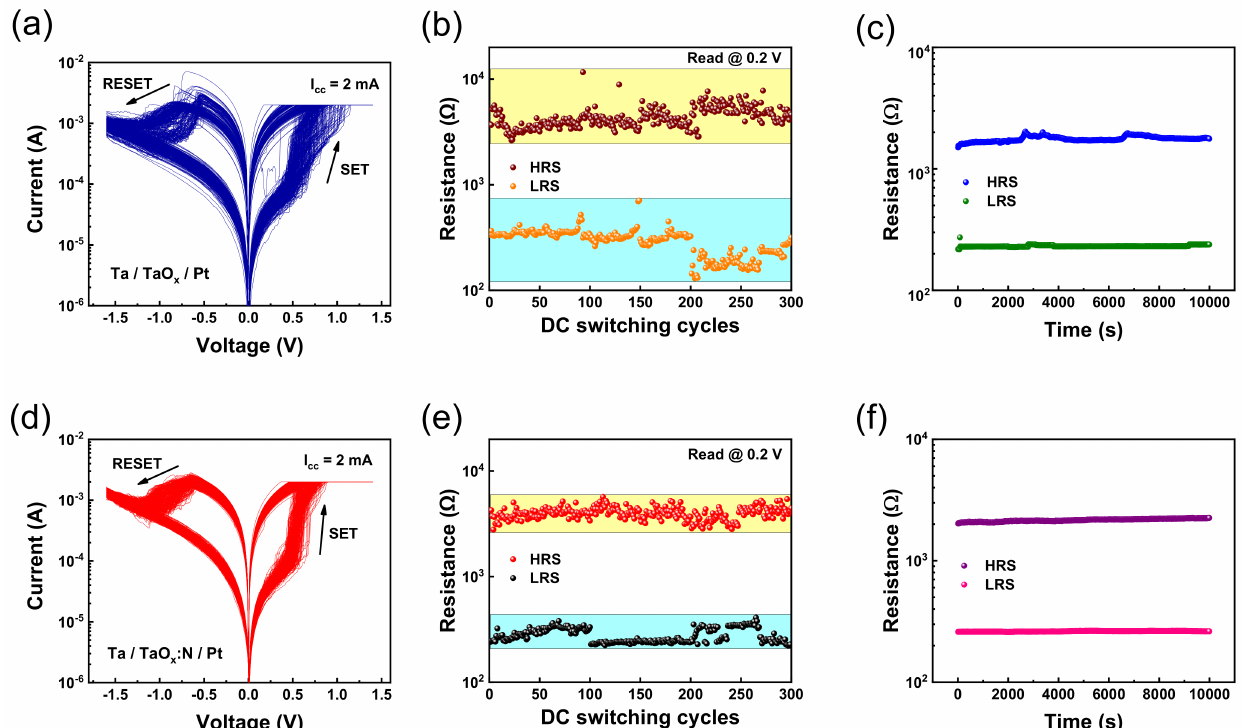
Figure 2. RS characteristics of Ta/TaO x /Pt device: ( a ) I − V curves of 300 consecutive switching cycles, ( b ) LRS and HRS state resistance distribution for each cycle at 0.2 V ( c ) Retention characteristics test for LRS and HRS. RS characteristics of Ta/TaO x :N/Pt device: ( d ) I − V curves of 300 repetitive switching cycles, ( e ) LRS and HRS state resistance measurement for each cycle at 0.2 V ( f ) Retention characteristics test for LRS and HRS.